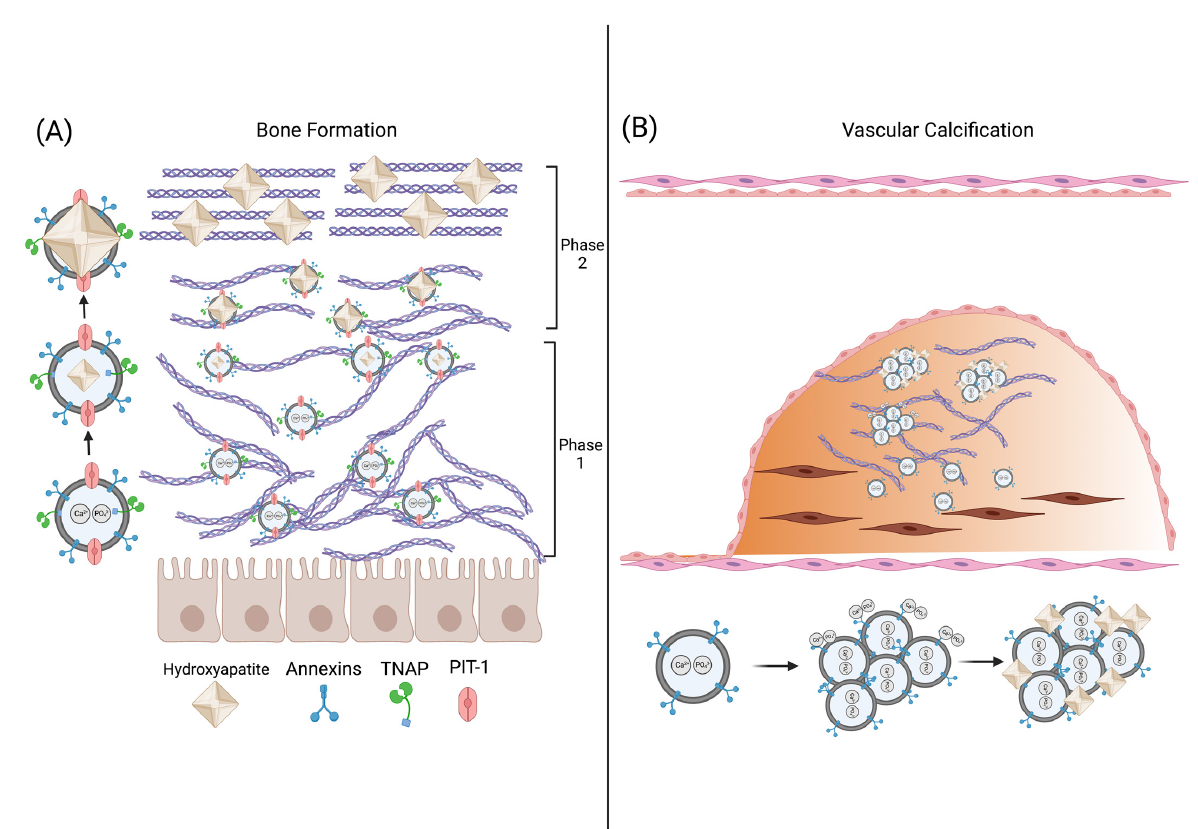
Figure 2. EV-mediated calcification of bone and the vasculature. ( A ) During phase 1 of mineralization during physiological bone formation, osteoblasts release matrix vesicles (MVs) which transport calcium and phosphate ions into the vesicle forming hydroxyapatite (HA) crystals. During phase 2 of mineralization, the HA crystals penetrate the MV and orient themselves with the ECM matrix, furthering crystal growth. ( B ) During vascular calcification, osteogenic-VSMC release EVs that aggregate and anchor to collagen within the ECM. Hydroxyapatite nucleation occurs on the surface of the EV aggregates.